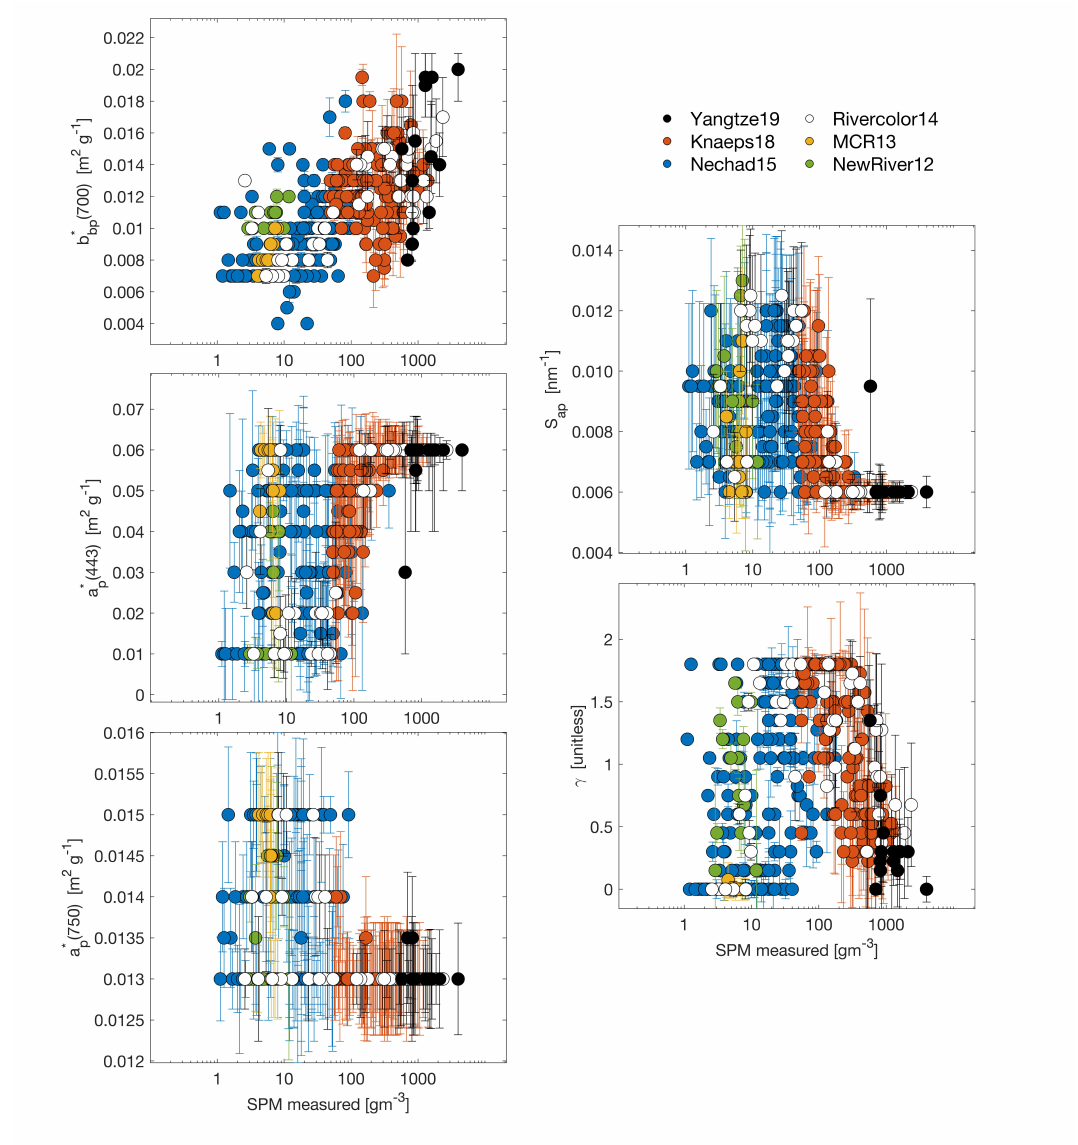
Figure 5. IOP constrained parameters from the MW algorithm as function of field measured